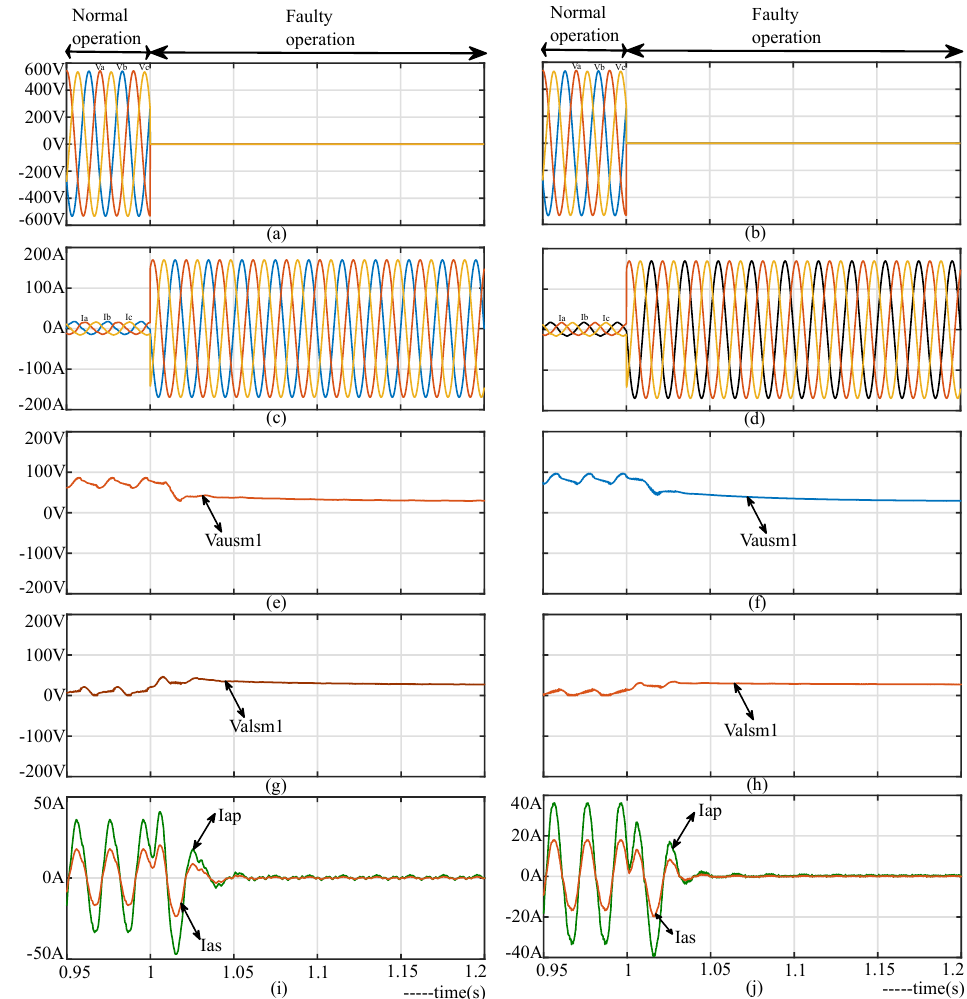
Figure 15. Converter during short circuited condition. ( a ) Line voltages of converter with d-q control and STHILSC, ( b ) line voltages of converter with d-q control and STHIPSC, ( c ) line currents of converter with d-q control and STHILSC, ( d ) line currents of converter with d-q control and STHIPSC, ( e ) STHILSC implemented upper arm phase-a SM-1 capacitor voltage, ( f ) STHIPSC implemented upper arm phase-a SM-1 capacitor voltage, ( g ) STHILSC implemented lower arm phase-a SM-1 capacitor voltage, ( h ) STHIPSC implemented lower arm phase-a SM-1 capacitor voltage, ( i ) primary and secondary phase-a transformer currents when STHILSC is implemented, ( j ) primary and secondary phase-a transformer currents when STHIPSC is